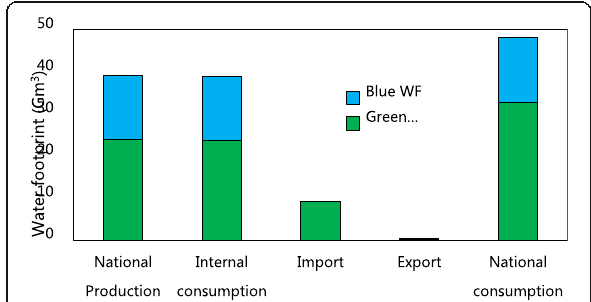
Fig. 7 Comparison of WF of wheat production, consumption